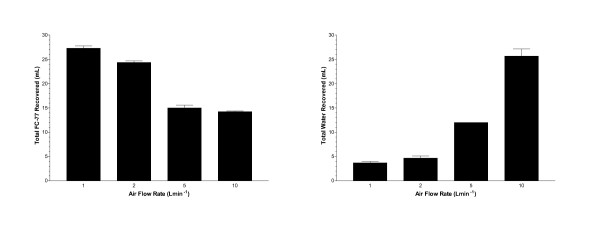
Recovered Volumes. Volumes of FC-77 and water recovered at different flow rates (mean ± sem). For FC-77, all pairs except 5 and 10 Lmin-1 are significantly different (p < 0.05). For water, all pairs except 1 and 2 Lmin-1 are significantly different (p < 0.05).